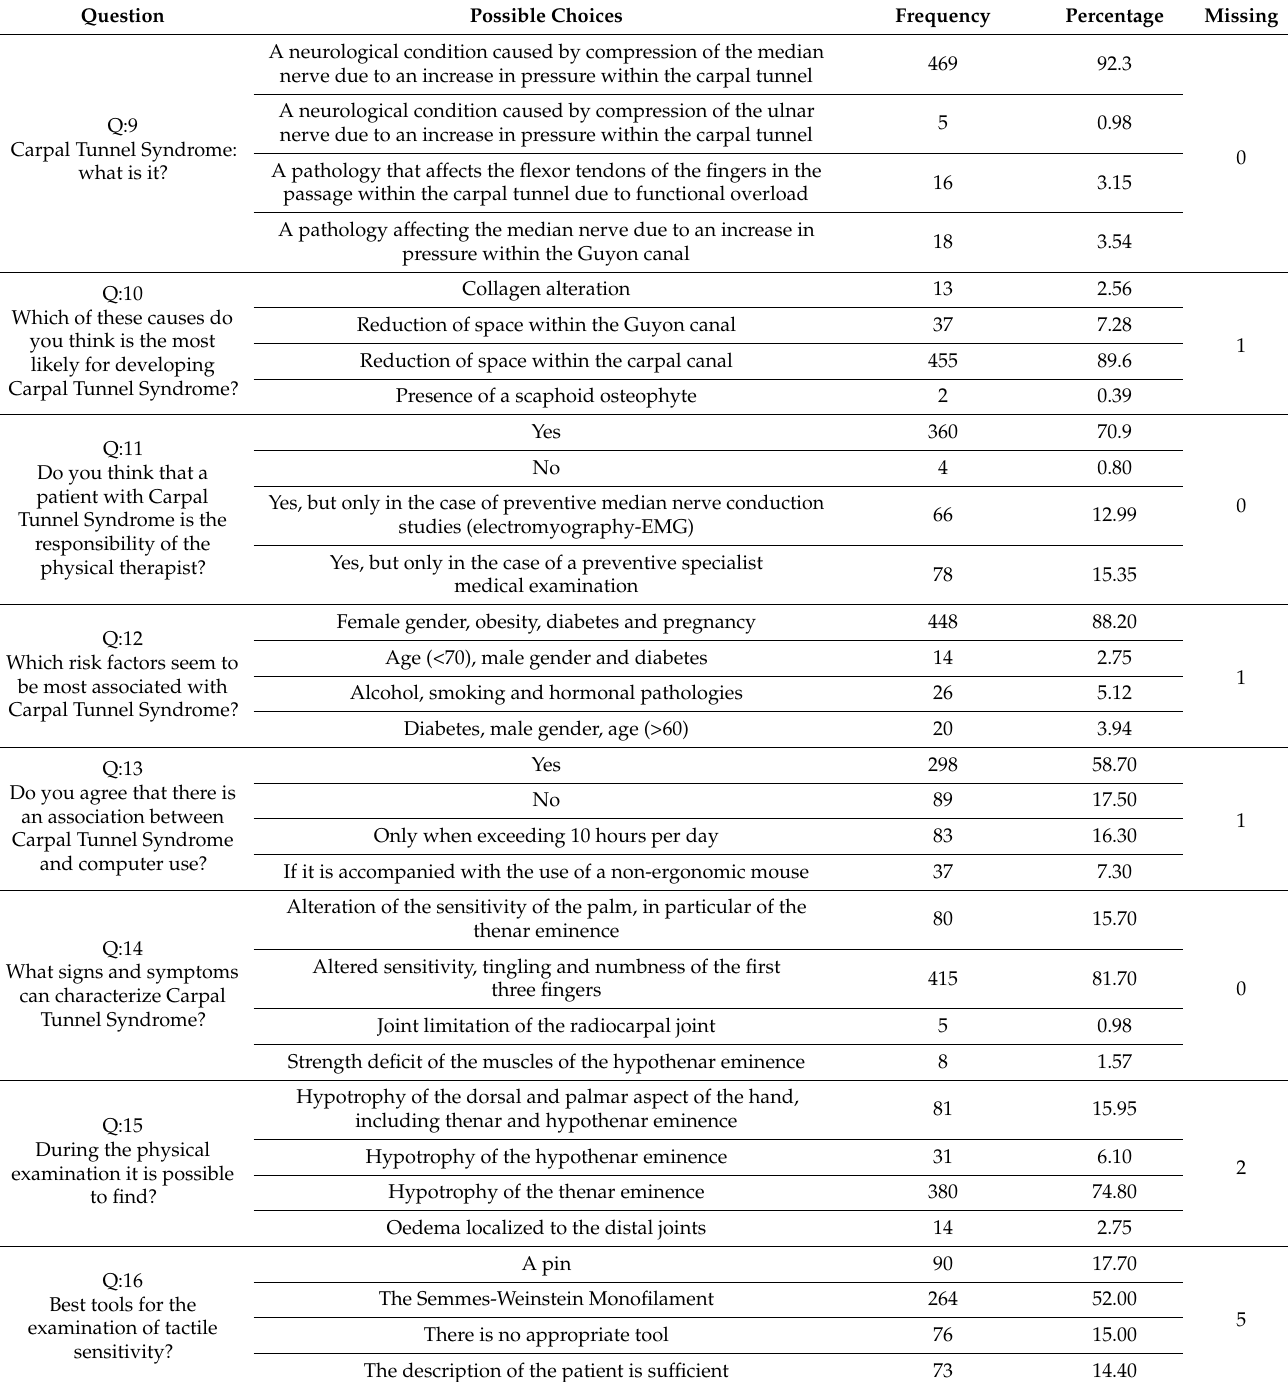
Table A1. Analytic